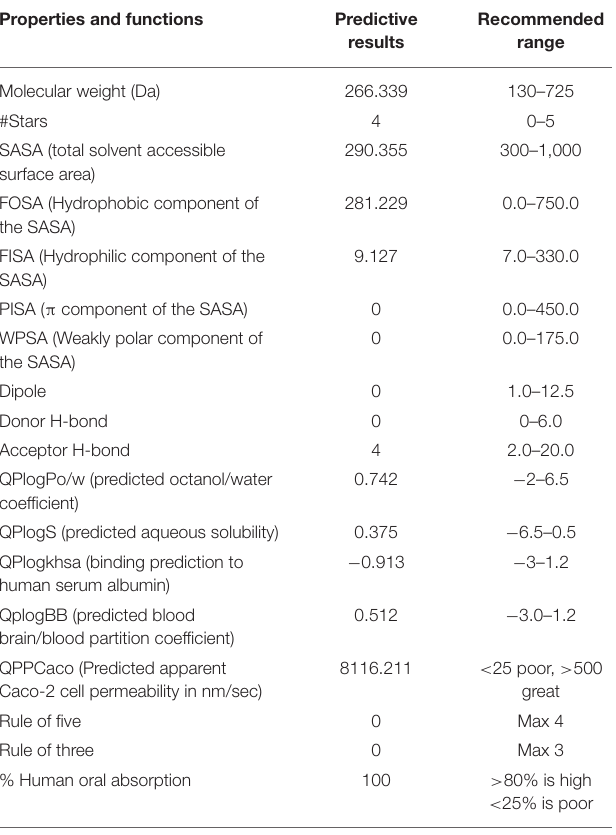
TABLE 3 | ADME prediction of cinnamyl dihydrocinnamate (CMNPD5348). Properties and functions